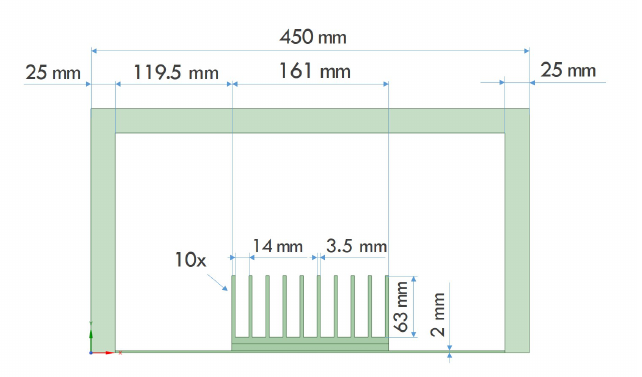
Figure 3. Domain dimensions in front